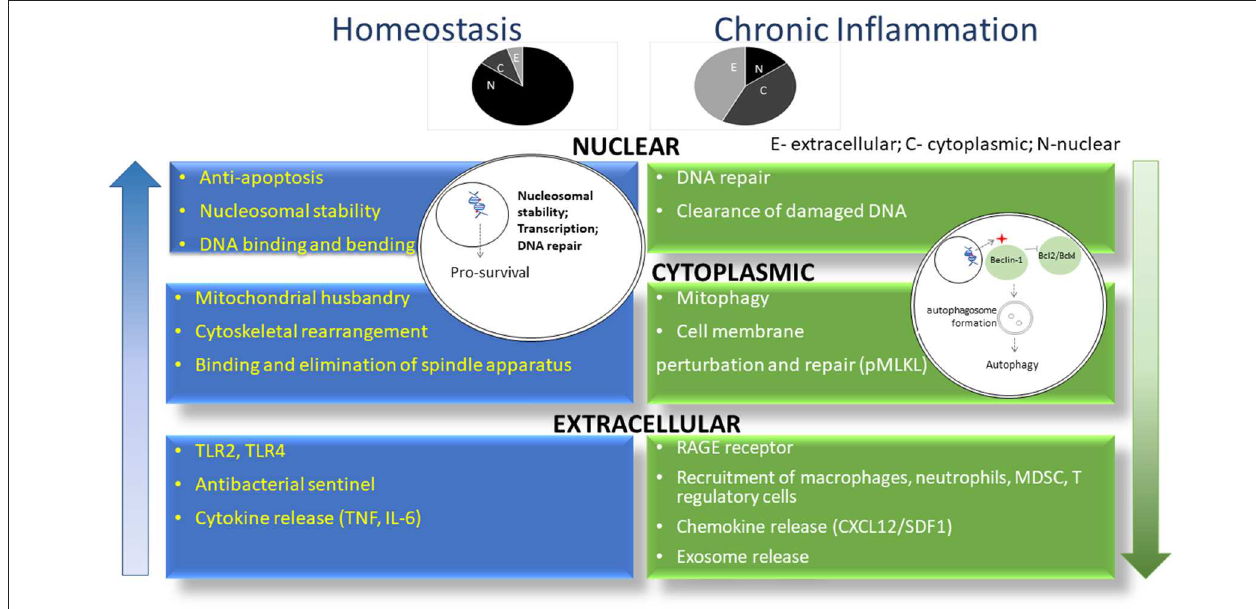
FIGURE 1 | HMGB1 exerts differential roles in homeostasis and chronic inflammation. As shown in blue, HMGB1 is predominantly located in the nucleus of cells in the setting of homeostasis, where it promotes nucleosomal stability and facilitates access of transcriptional factors to DNA. In chronic inflammation (green), HMGB1 leaves the nucleus to drive autophagy in the cytoplasm and act as a DAMP in the extracellular milieu . Shown above are the relative proportion of HMGB1 in individual compartments during homeostasis and chronic inflammation. N, nucleus; C, cytoplasm; E,